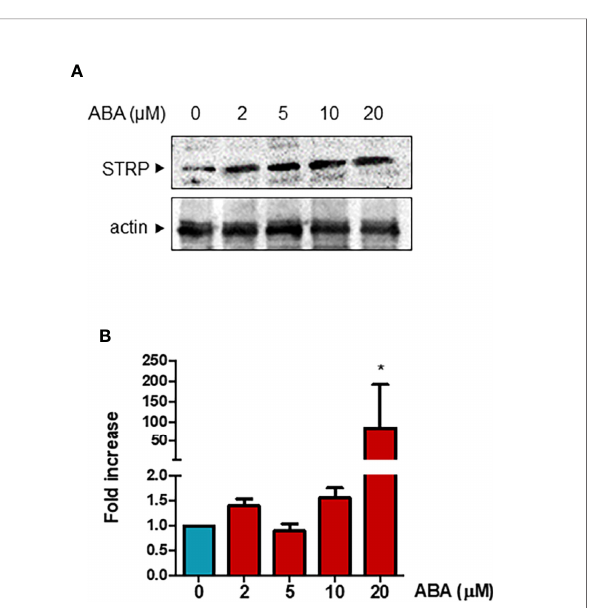
FIGURE 7 | ABA treatment activates STRP expression and increases STRP levels. STRP levels and gene expression were assessed on 2-week-old seedlings treated with 2, 5, 10, and 20 µM ABA for 18 h. STRP levels were determined by western blot (Panel A ) on 20 m g of total extract. Samples were separated by SDS-PAGE, transferred on PVDF membrane and incubated with the anti-STRP antibodies. Actin was used as loading control. STRP expression levels (Panel B ) were determined on total RNA extracted from A. thaliana , retrotranscribed and analysed by RT-qPCR. mRNA levels were normalized to beta 8-tubulin mRNA ( TUB8 ). Error bars are S.E.M. of four independent experiments. *P < 0.01, by Student ’ s